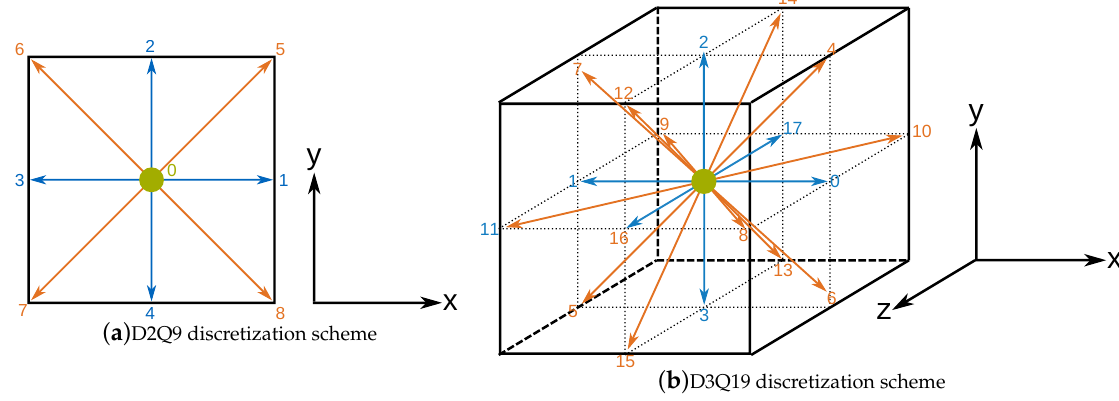
Figure 1. Discretization schemes for the LBM using q = 9 probability densities in 2D ( a ) and q = 19 probability densities in 3D ( b ), respectively [19]. Blue arrows represent probability densities with √ lattice speed c i = 1, red arrows with lattice speed c i = 2, and green dots with lattice speed c i = 0. The orientation of the corresponding coordinate systems is indicated in the right parts of the